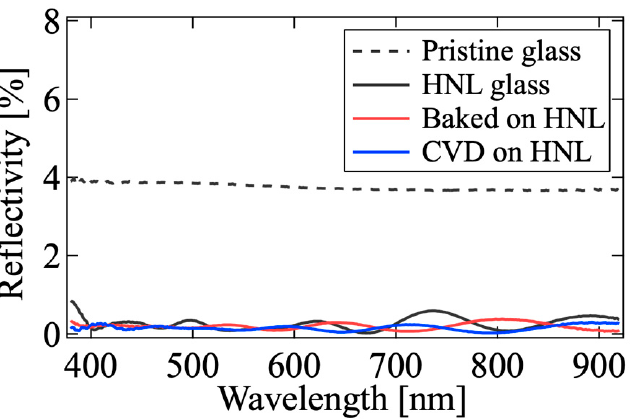
Figure 5. The reflectivity spectra of the PDMS-treated (120 min) HNL glass compared to the pristine and untreated HNL glass. Both samples treated by baking and CVD maintained the anti-reflection property that untreated HNL intrinsically has.